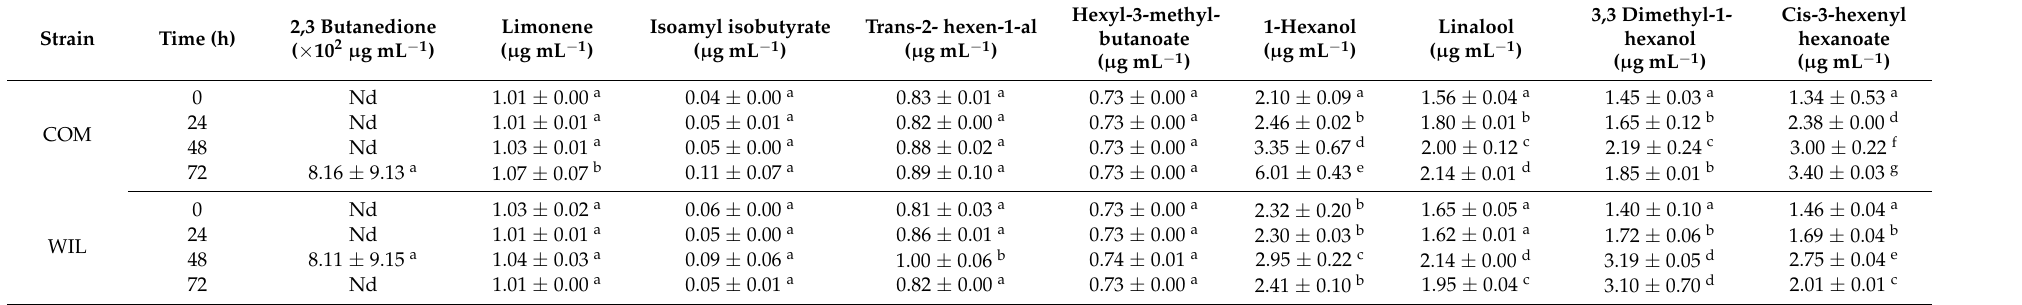
Table 3. Concentrations of volatile compounds in the fermentation of Habanero pepper.